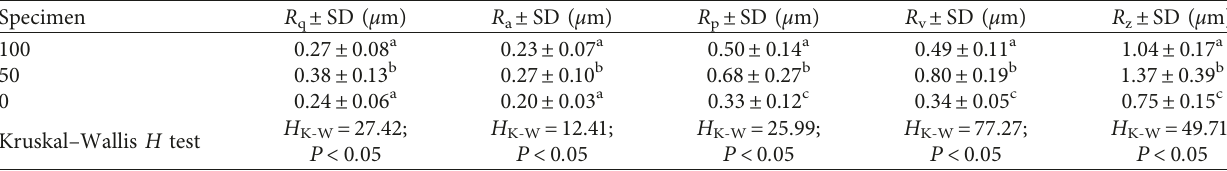
Table 3: The mean values of surface roughness parameters (with SD values) and Kruskal–Wallis H parameter.